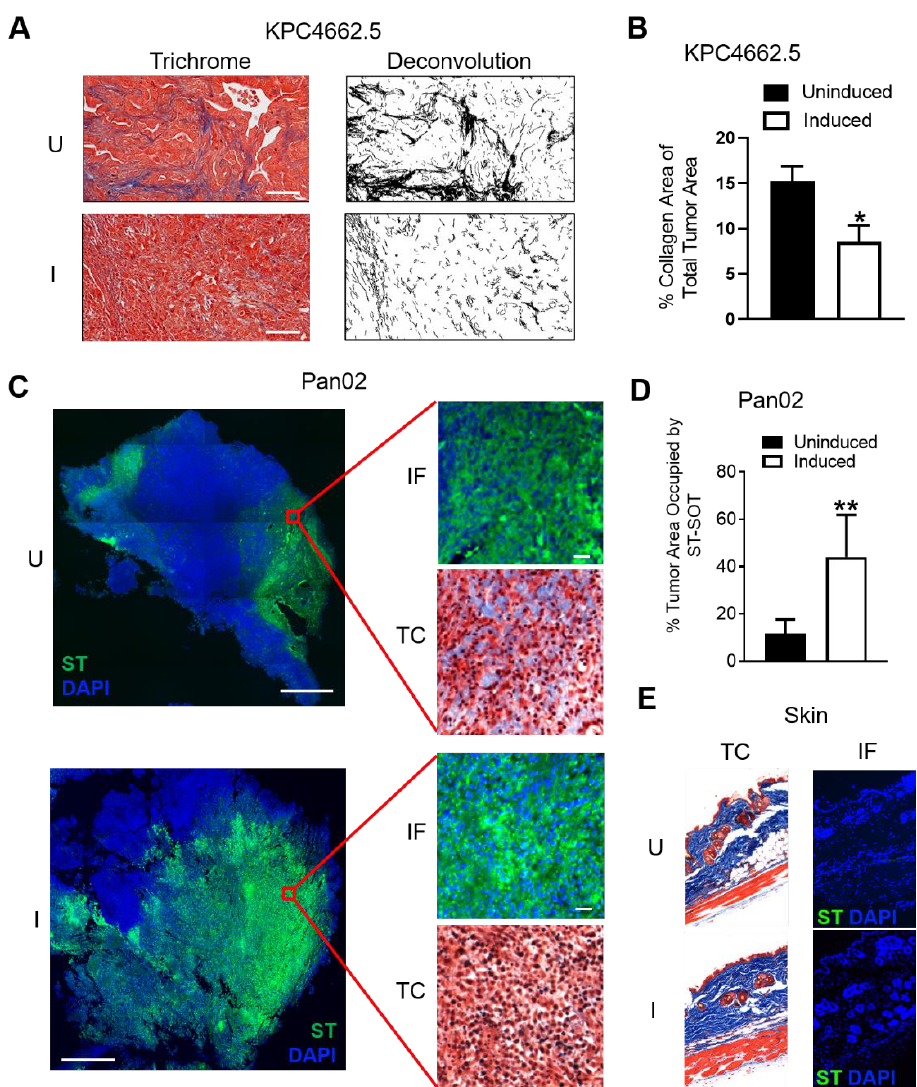
Figure 3. Induction of ST-SOT leads to intratumoral CN depletion and enhanced ST diffusion in vivo. ( A ) C57BL/6 mice bearing orthotopic KPC4662.5 tumors (>150 mm 3 ) were administered 5 × 10